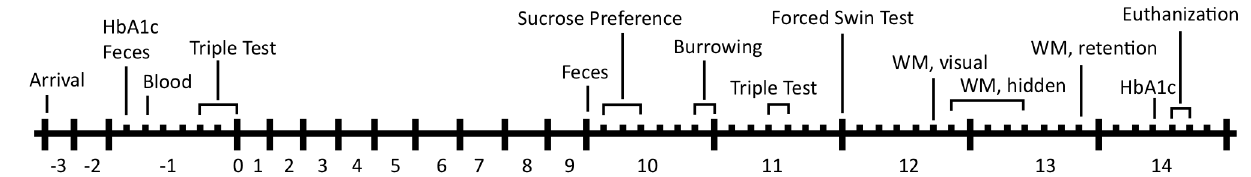
Figure 1. Timeline illustrating the experimental period. Numbers indicate week number, with mice subjected to the experimental diets from time 0. HbA1c: Glycosylated hemoglobin 1c, WM: Water Maze.